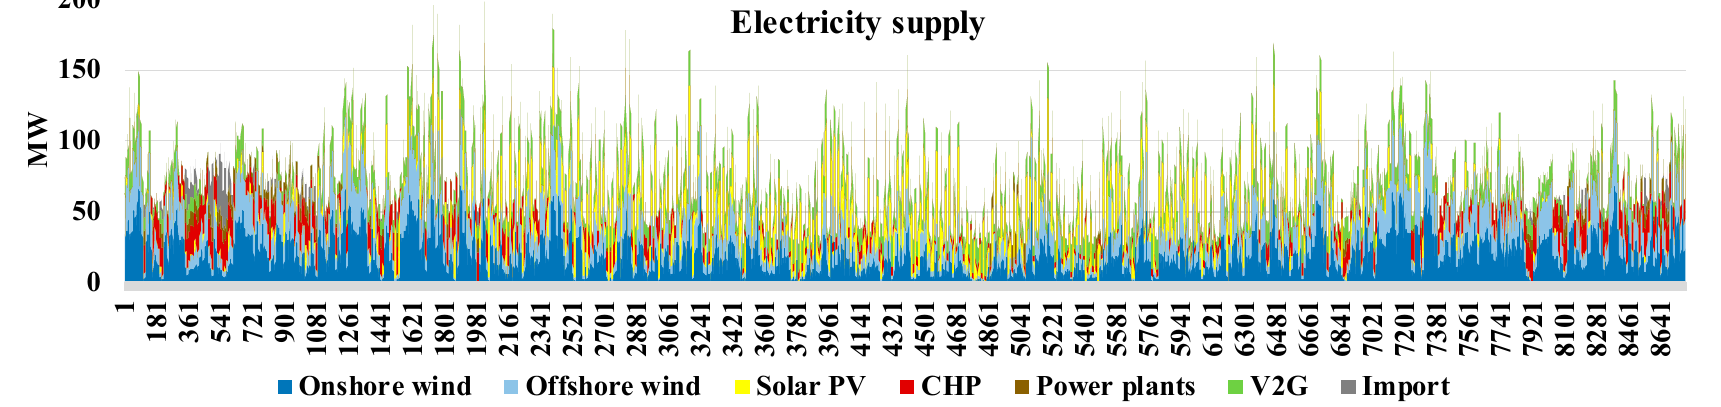
Figure 3. Annual hourly power supply by category (MW e ). A seasonal complement can be observed between solar PV and CHP electricity production. Solar PV is also seasonally complemented by wind power to a lesser extent.